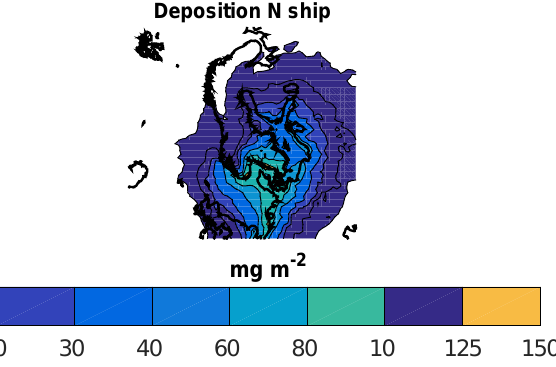
Figure 14. Percentage (%) of the total surface concentration, caused by international shipping in the Baltic Sea and the North Sea in 2011.